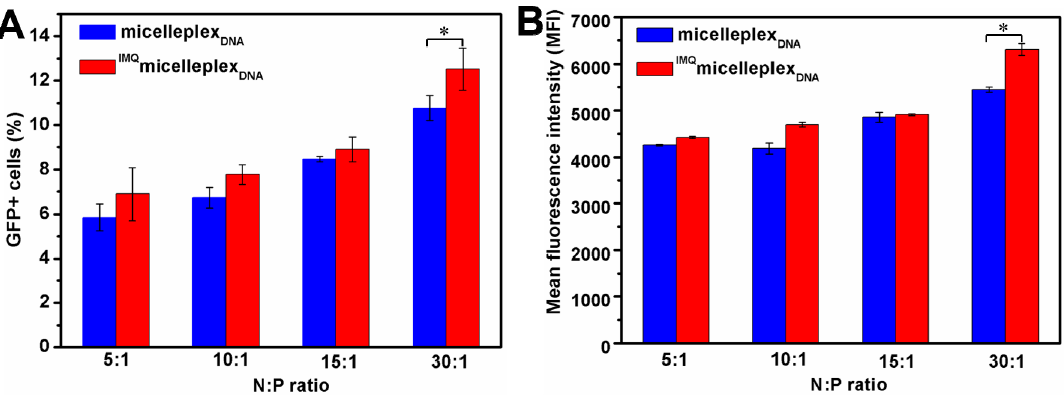
Figure 8. Transfection efficiency of DC2.4 cells by micelleplexes determined by flow cytometry. Quantification by the percentage of transfected GFP + cells ( A ) and mean fluorescence intensity ( B ). * p < 0.05.